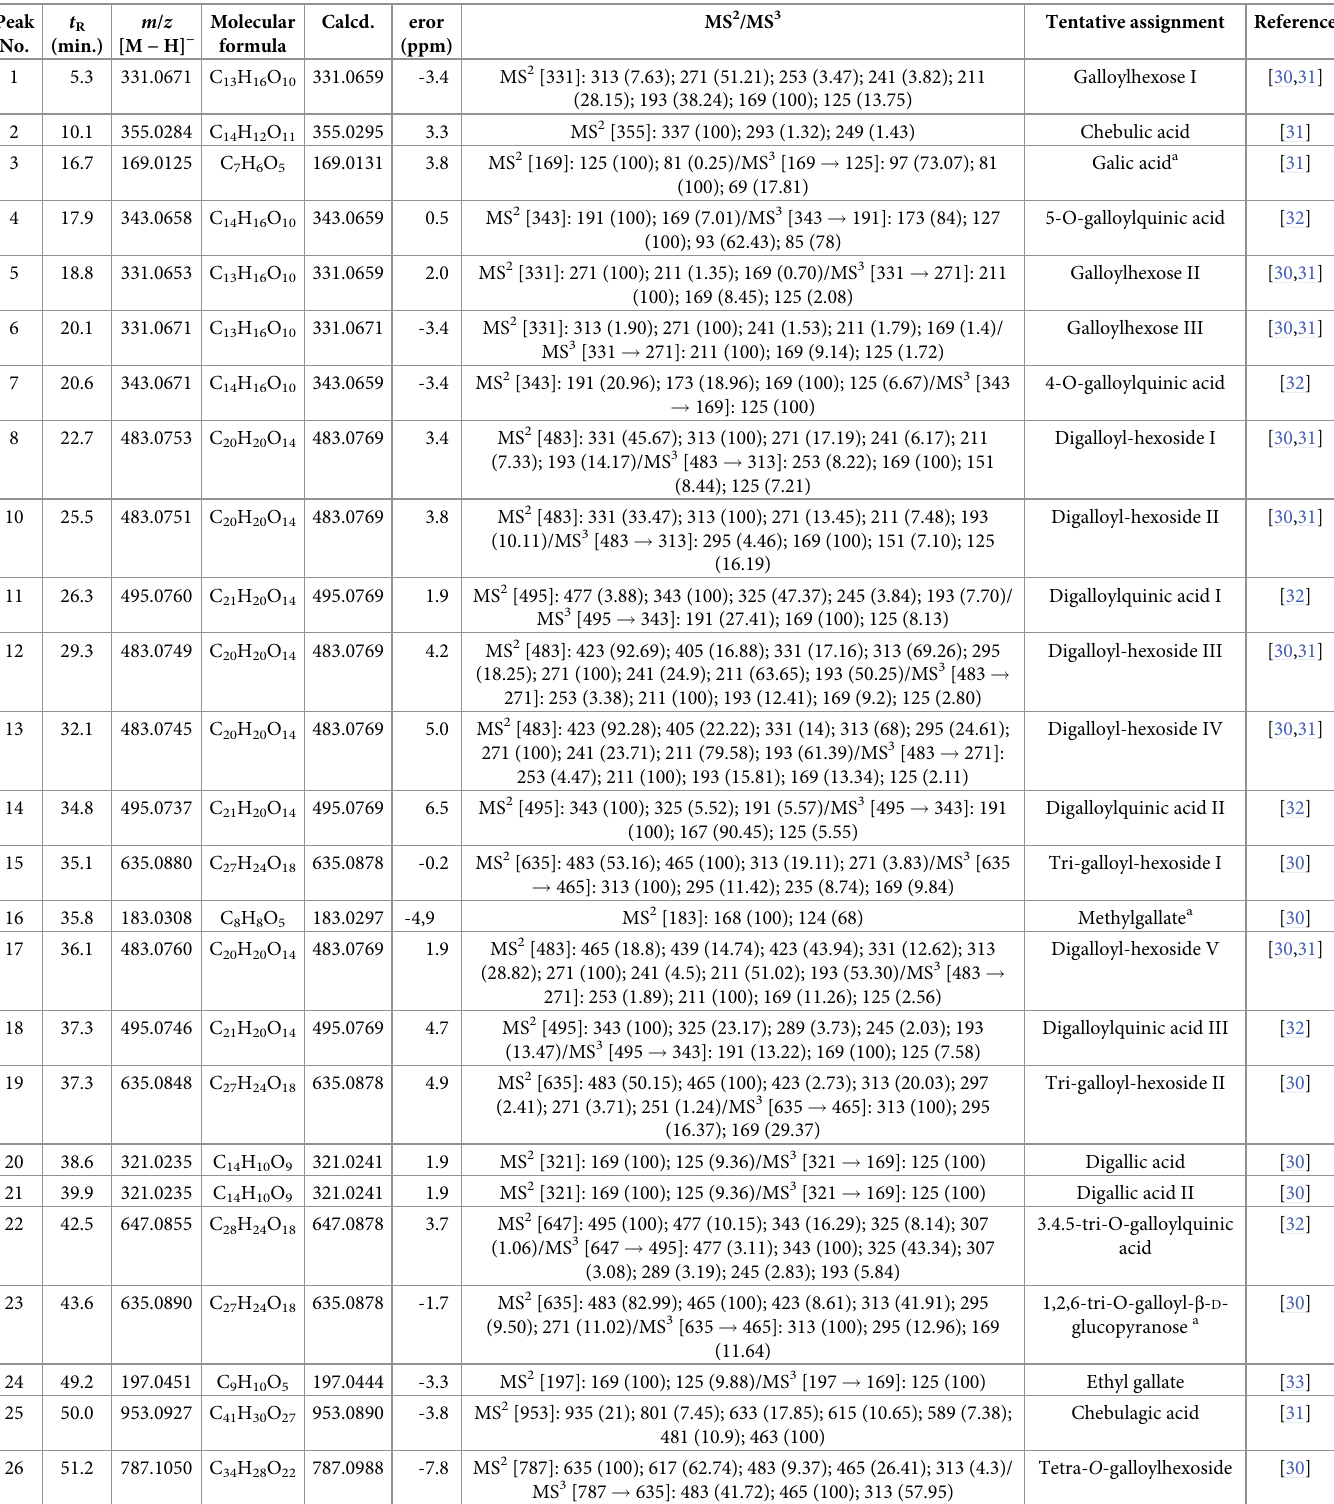
Table 1. Characterization of the compounds tentatively identified by HPLC-ESI-MS n in Dictyoloma vandelliaum . Peak t R No.